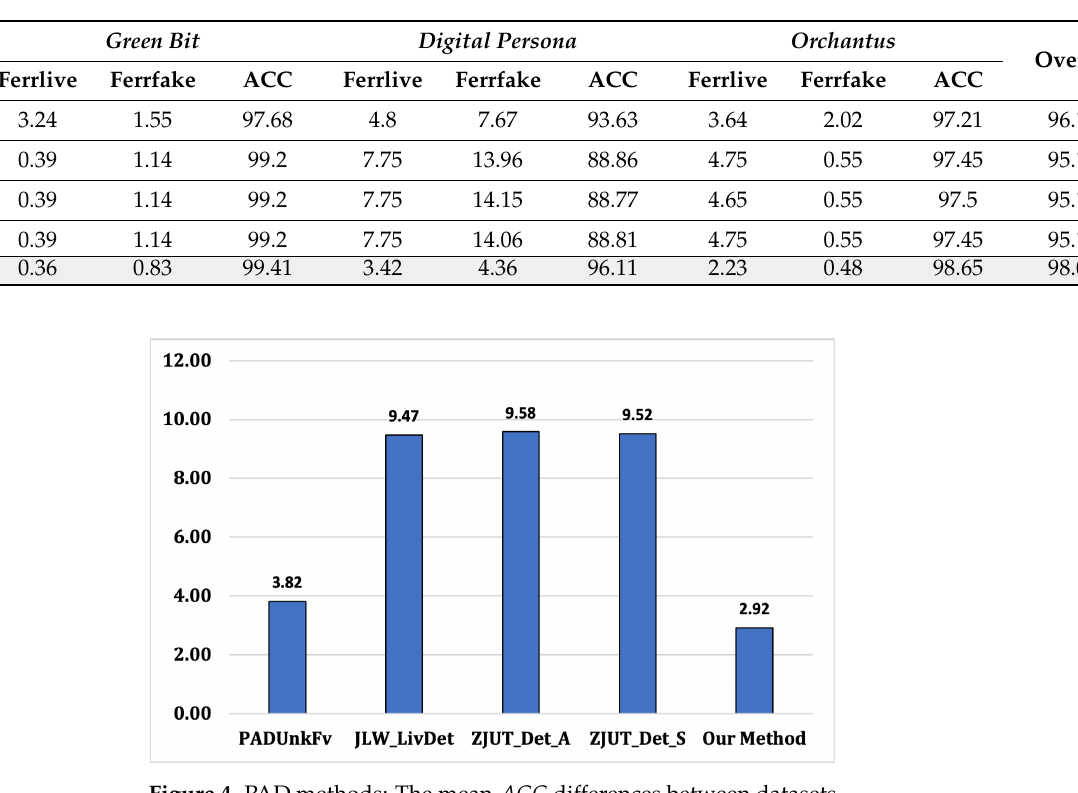
Table 3. The performance comparison between existing PAD methods.